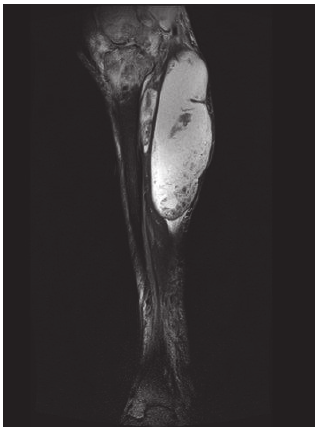
Figure 2: Sagittal T2-1 image from magnetic resonance imaging of right